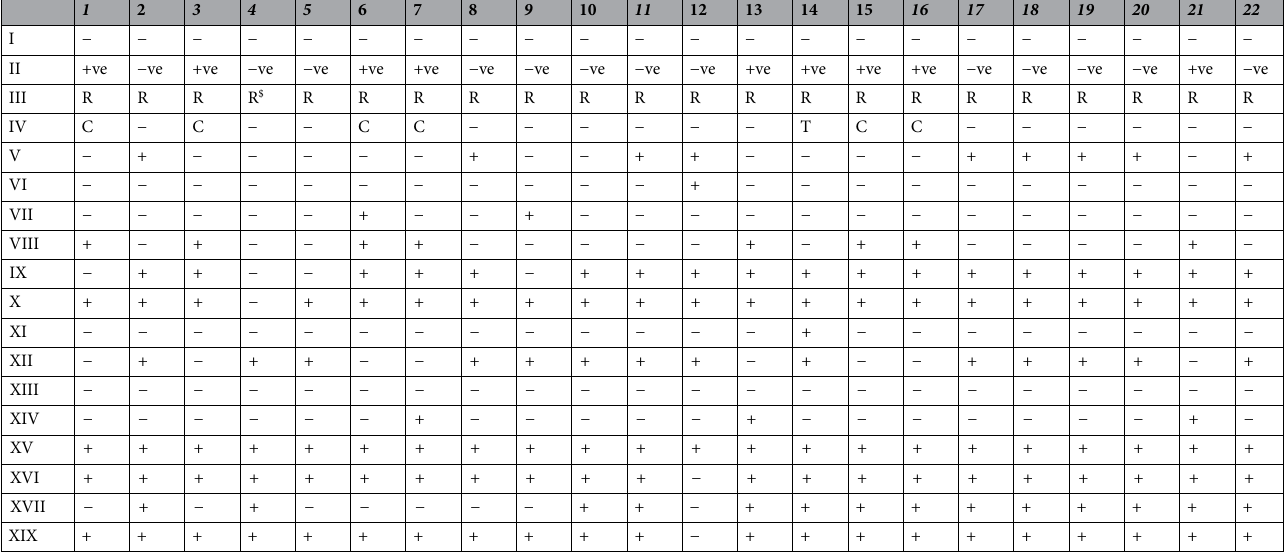
Table 1. Physio-biochemical attributes of the isolated microflora. 1: Bacillus foraminis strain skuast2; 2: Enterobacter cloacae strain SKUAST-K4; 3: Bacillus firmus strain SKUAST-K10; 4: Salinivibrio costicola strain SKUAST-K11; 5: Pantoea agglomerans strain SKUAST-K12; 6: Bacillus subtilis strain smppsap1; 7: Bacillus subtilis strain smppsap2; 8: Pseudomonas koreensis strain SKUAST-K16; 9: Serratia marcescens strain SKUAST-K24; 10: Comamonas terrigena strain SKUAST-K31; 11: Pseudomonas fragi strain SKUAST-K32; 12: Delftia acidovorans strain SKUAST-K35; 13: Bacillus amyloliquefaciens strain SKUAST-K43; 14: Bacillus subtilis strain SKUAST-K45; 15: Bacillus velezensis strain SKUAST-K46; 16: Bacillus velezensis strain SKUAST-K49; 17: Pseudomonas synxantha strain SKUAST-K50 ; 18: Pseudomonas fluorescens strain smppsap4; 19 : Pseudomonas mucidolens strain SKUAST-K53; 20: Pseudomonas lurida strain SKUAST-K54; 21: Bacillus pumilus strain smppsap6; 22: Pseudomonas veronii strain SKUAST-K67I : Pigment production;II: Gram reaction;III: